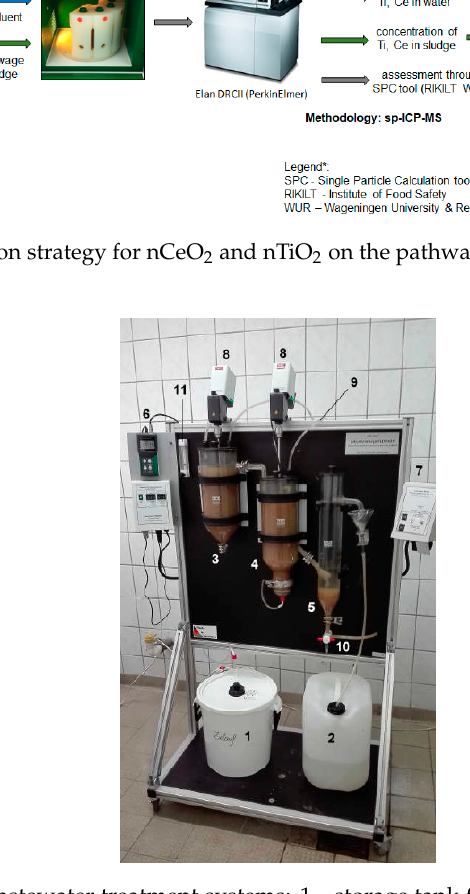
Figure 2. Lab-scale wastewater treatment systems: 1—storage tank for feed water, 2—storage tank for